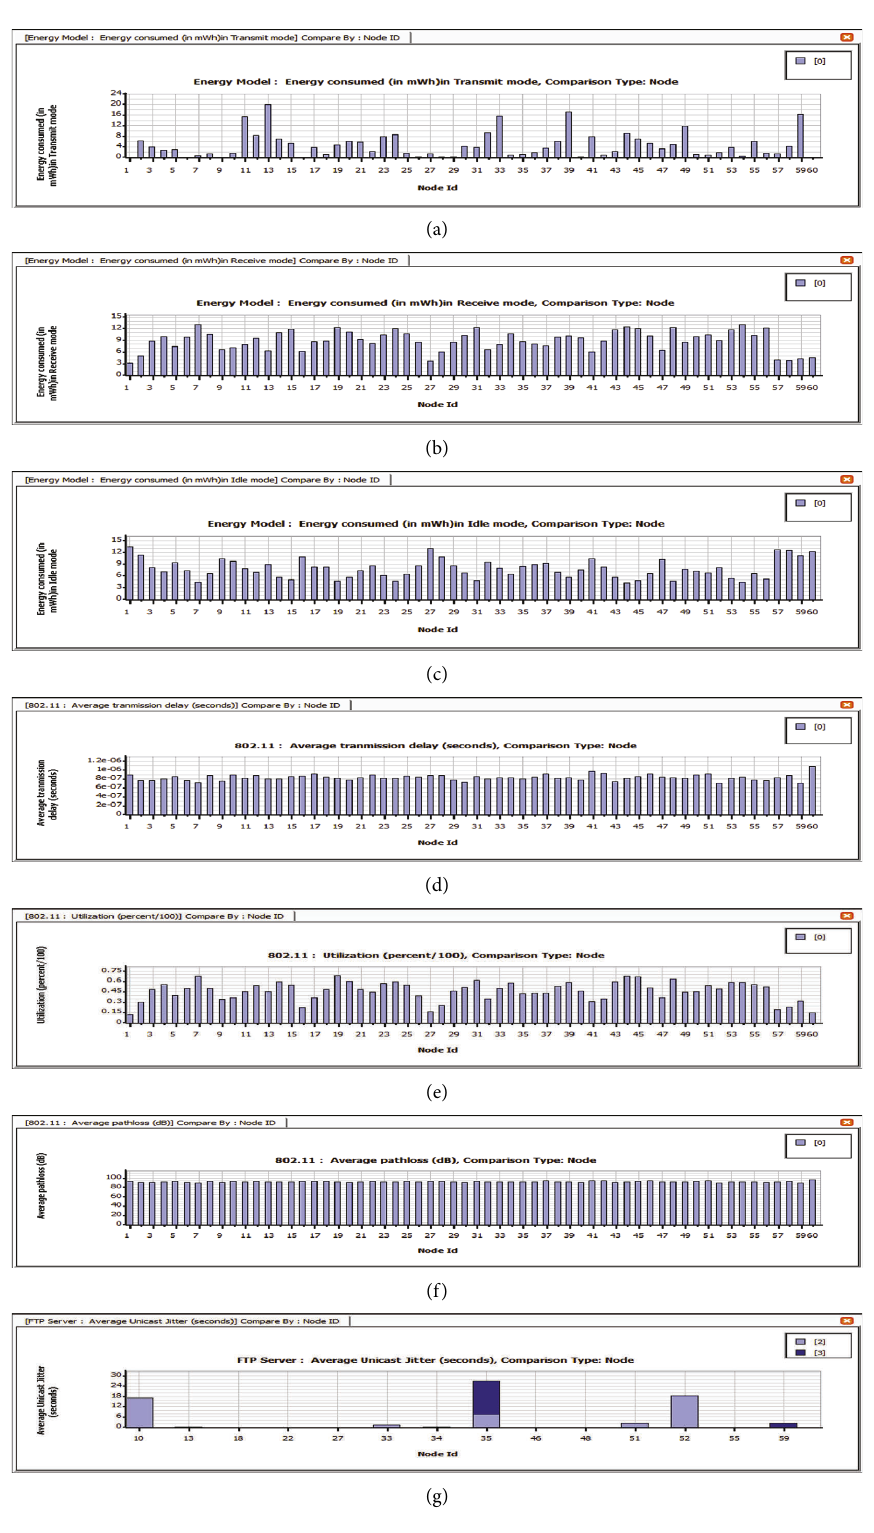
Figure 14: (a) Transmit mode energy consumption of Fisheye for FTP deployment. (b) Receive mode energy consumption of Fisheye for FTP deployment. (c) Idle mode energy consumption of Fisheye for FTP deployment. (d) Average transmission delay of Fisheye for FTP deployment. (e) Percentage of utilization of Fisheye for FTP deployment. (f) Average pathloss of Fisheye for FTP deployment. (g) Average jitter of Fisheye for FTP